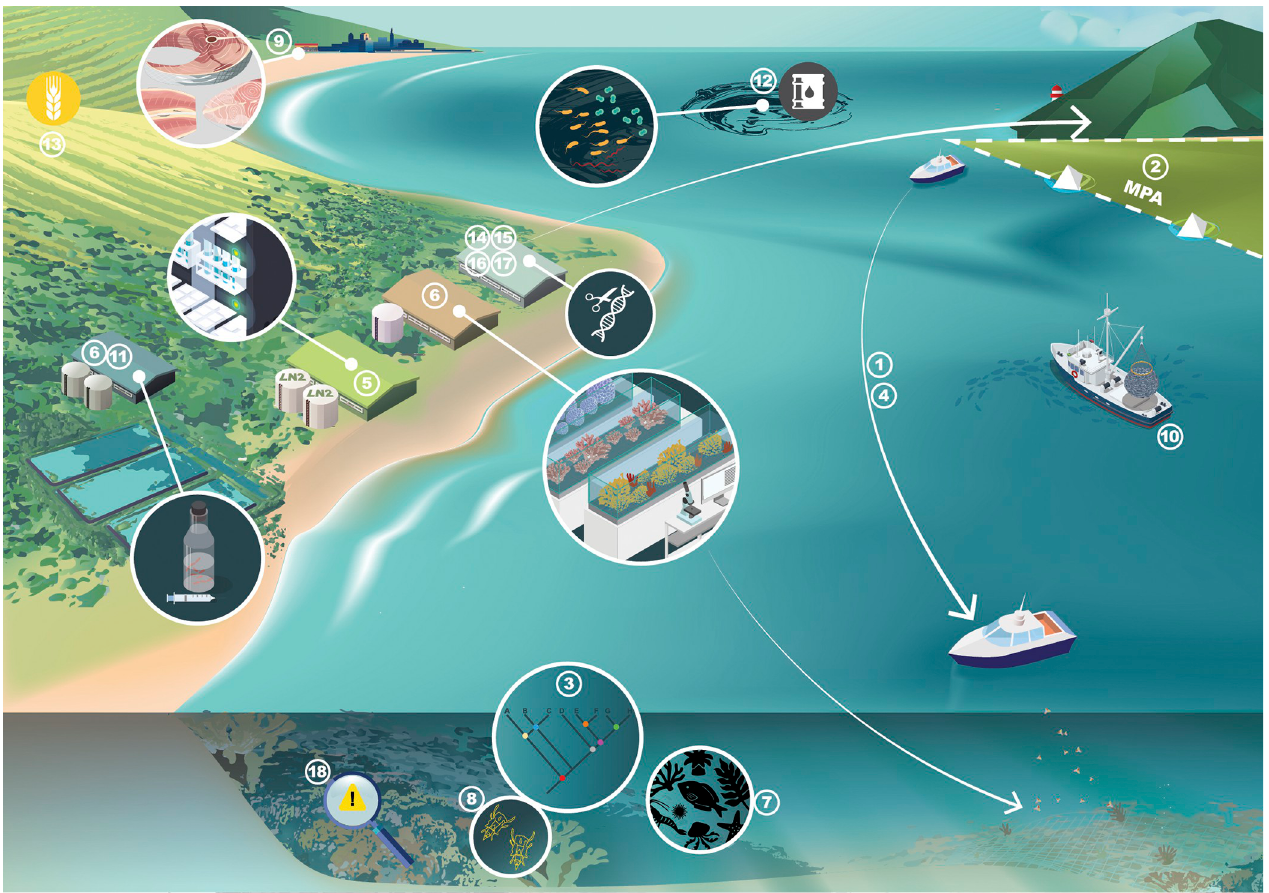
Fig 1. Infrastructure for genomic/genetic marine conservation actions and interventions. Cartoon depicting the conservation actions and interventions addressed in this Essay and showing the major infrastructure required for each. Numbers relate to actions/interventions in Table